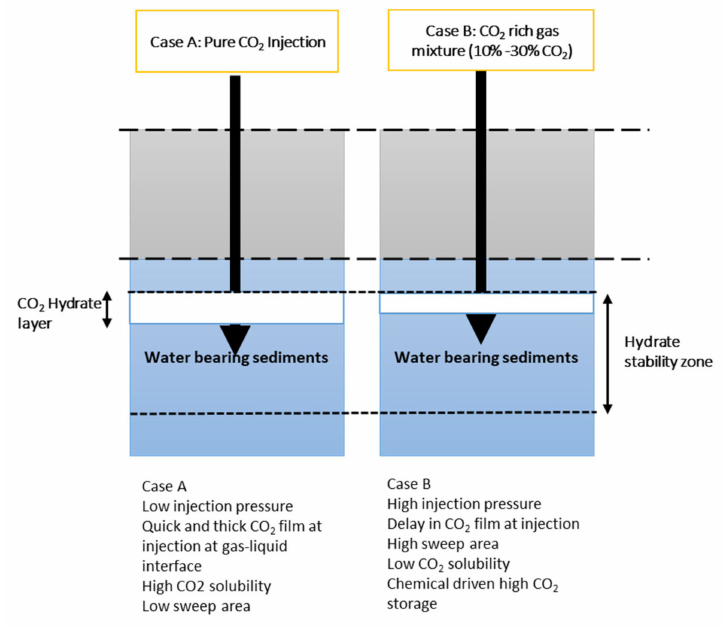
Figure 3. Conceptual layout indicating CO 2 storage in water-bearing sediments (including methane hydrate) when pure CO 2 is injected and when CO 2 -rich gas mixture is